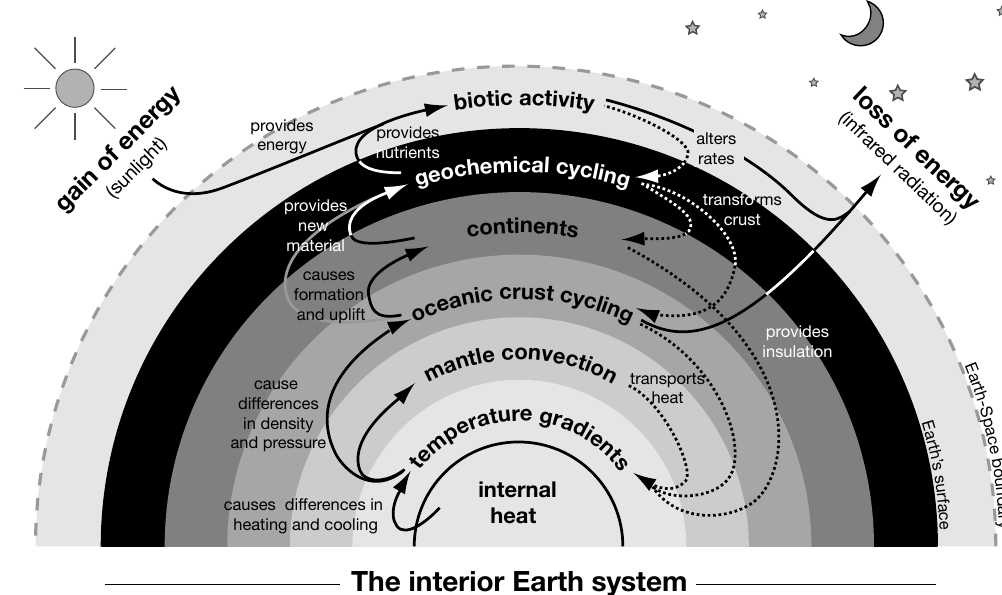
Fig. 1. A highly simplified schematic that represents the major pathways of surface-interior interactions. Interior processes can be seen as being driven by the flow of heat from the interior of the Earth. These processes are represented with solid lines. However, such processes are sensitive to alterations to their boundary conditions that are represented by dashed